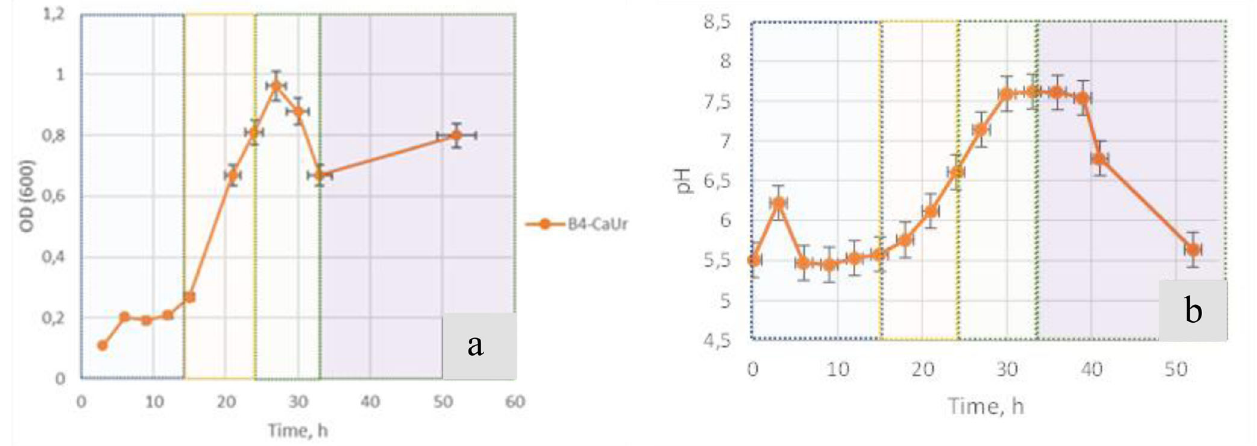
Fig. 1 Biomass growth characteristics of B. cereus 4B in the B4_CaUr medium (with an excess of calcium and urea ions). a Time- dependence of the bacterial biomass growth; b Time-dependence of the medium acidity during the incubation. Time stages are highlighted in color: 0 – 15 h in blue; 15 – 24 h in orange; 24 – 33 h in green; more than 33 h in